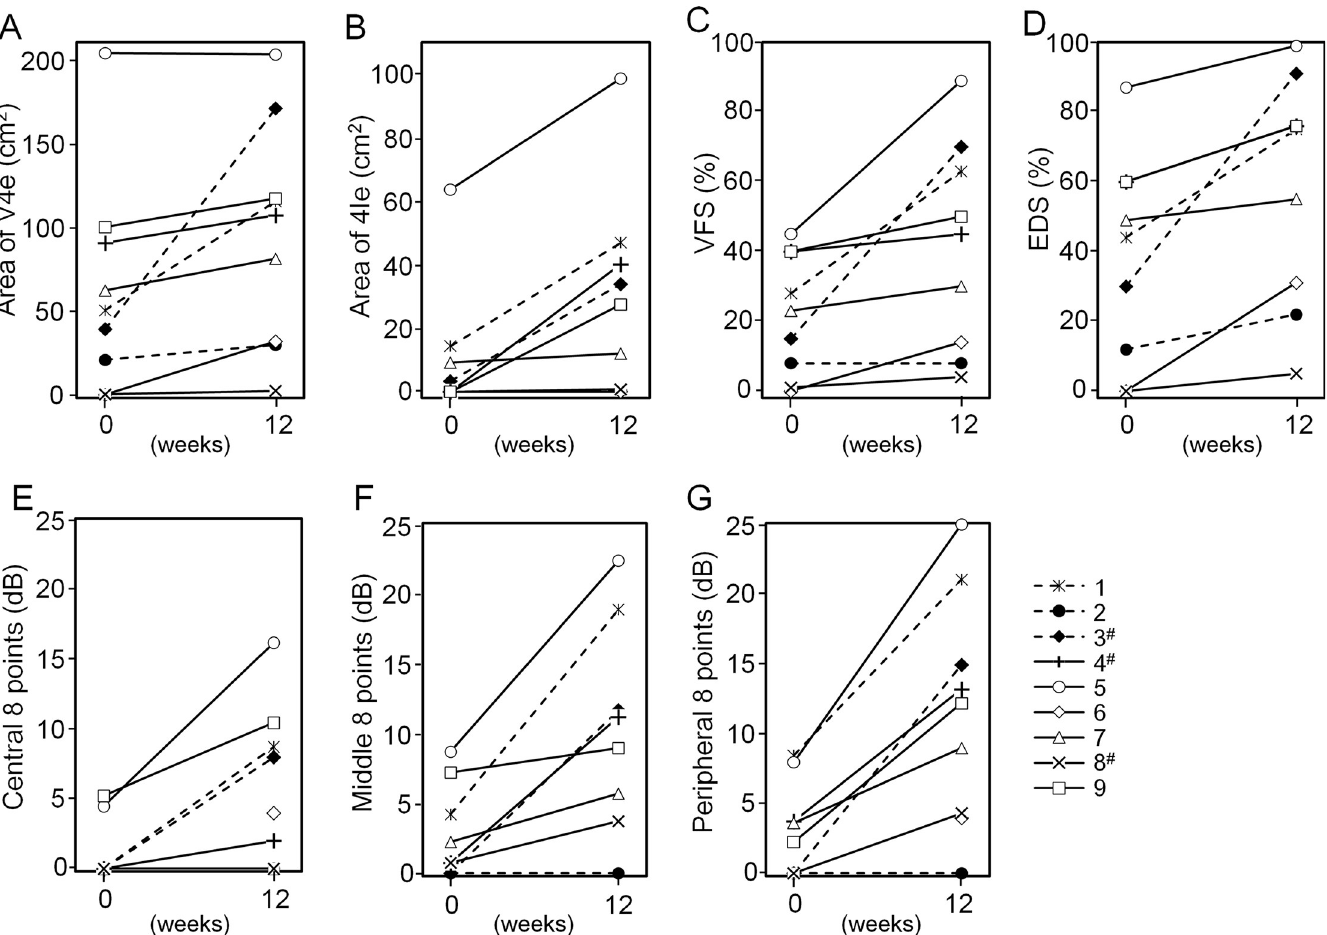
Fig 3. Visual field and retinal sensitivity changes from baseline to week 12 in individual patients. (A, B) Comparison of area on the visual field (V4e in A, I4e in B) (C, D) Comparison of visual field (C) and Esterman disability (D) scores on the visual field (V4e isopter). (E-G) Comparison of retinal sensitivity (central 8 points in E, middle 8 points in F, peripheral 8 points in G). #: patient with patent cilioretinal artery in the objective eye.